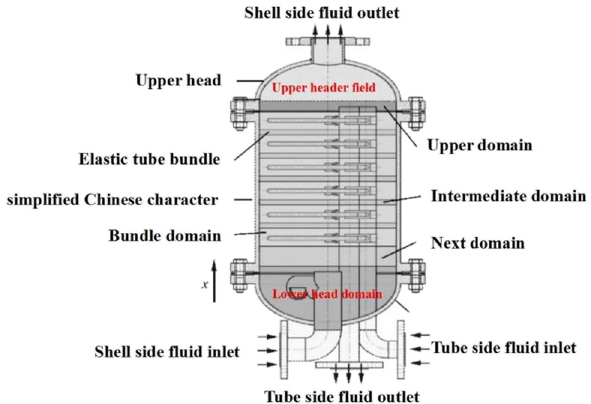
Figure 1: Schematic diagram of elastic tube bundle heat exchanger and its shell side fl uid